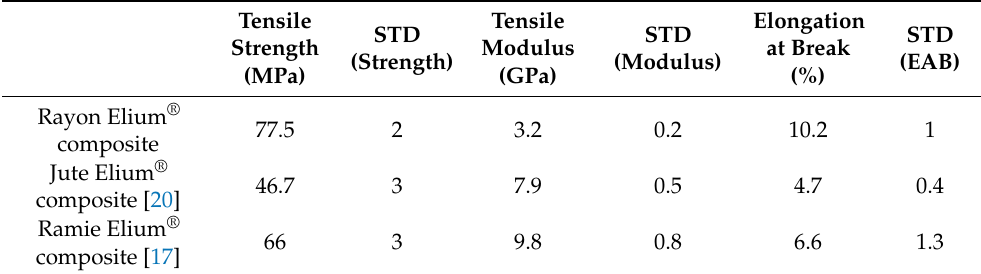
Table 1. Average tensile strength, modulus and elongation at break (EAB) of the rayon fibre composite compared to its NF counterparts.